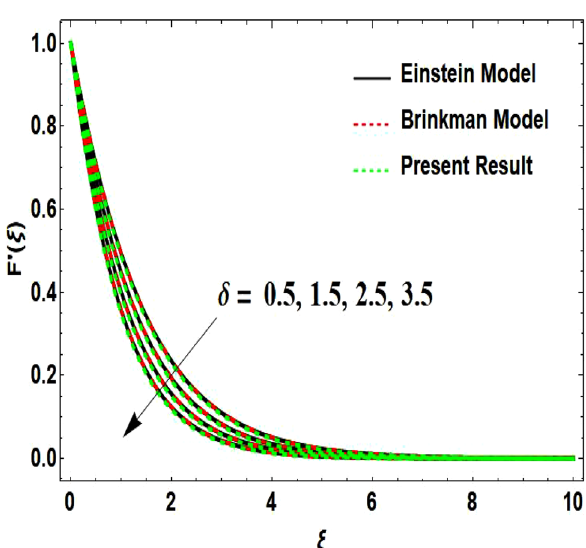
Figure 8. Velocity curve influenced by surface wall thickness